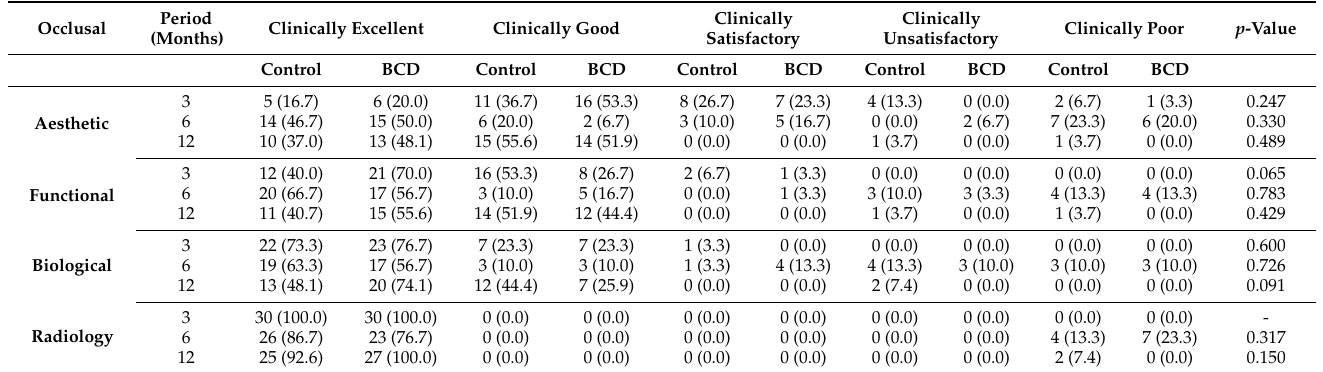
Table 3. Aesthetic, functional, biological, and radiological post-operative evaluation at 3, 6, and 12 months among the groups (Occlusal caries).